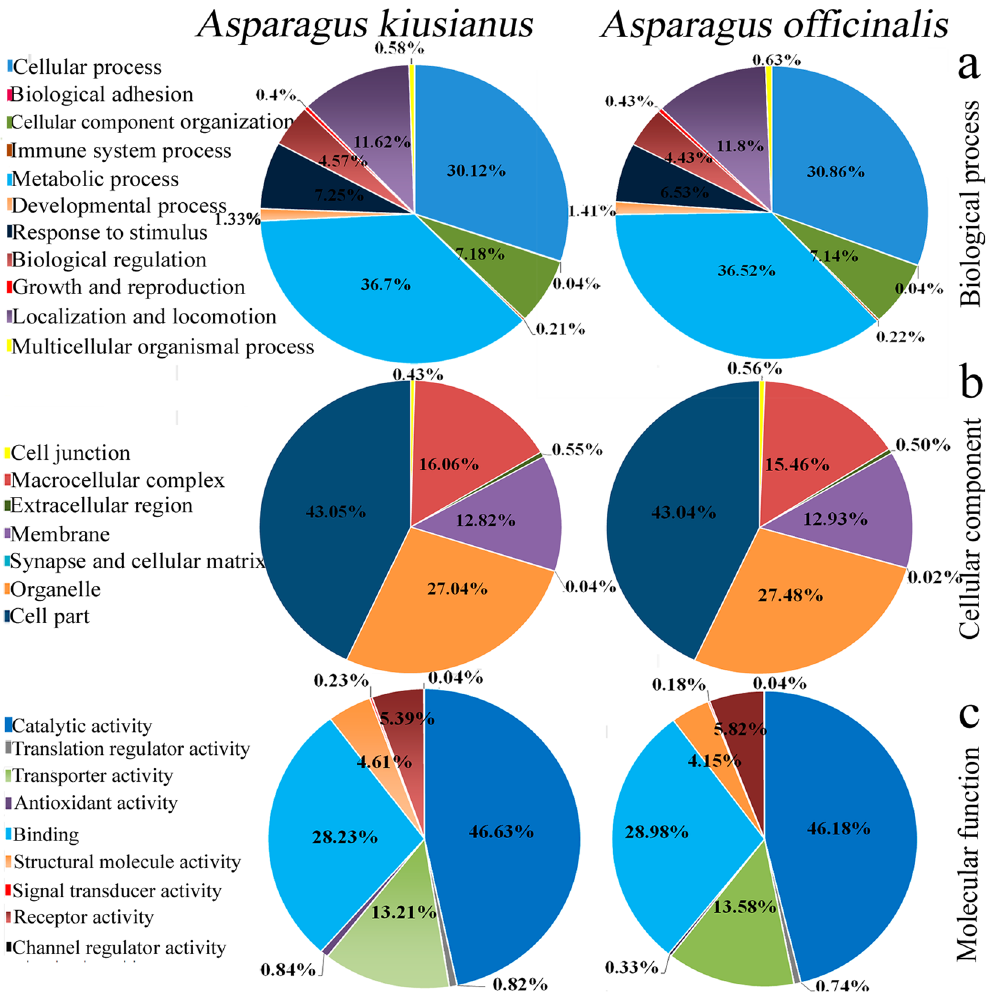
Figure 3. Pie chart of gene ontology (GO) analysis of Asparagus officinalis and A . kiusianus . Results are summarized for the three main GO categories: ( a ) biological process, ( b ) cellular component, and ( c ) molecular